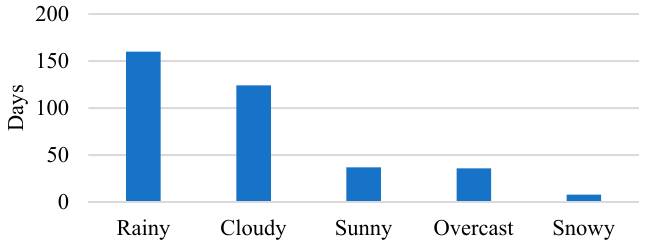
Figure 10. Distribution of different weather days in a year in Jinyun County.